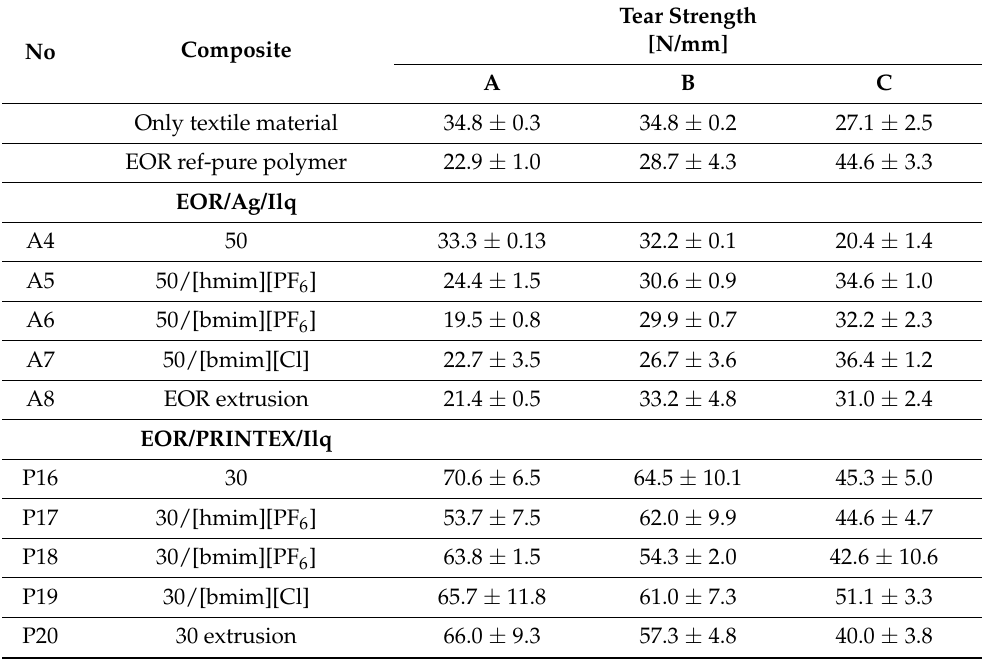
Table 5. The test results of measurements of tear strength of the composite polymer